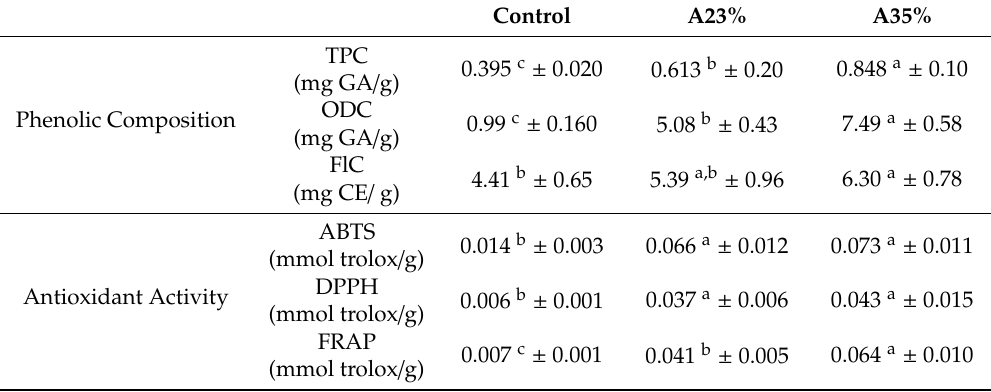
Table 5. Phenolic composition and antioxidant activity of the GFB with the incorporation of di ff erent ratios of acorn flour (A23% and A35%) and comparison with the control samples. ABTS: 2,2-azino-bis (3-ethylbenzothiazoline-6-sulphonic acid) diammonium salt, DPPH: diphenyl-1-picrylhidrazyl radical, FlC: flavonoids content, FRAP: ferric reducing antioxidant power, OPC: Ortho -diphenols content, TPC: total phenols content.